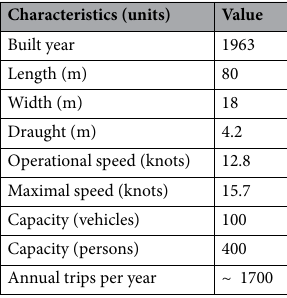
Table 1. Technical details of the N.M.